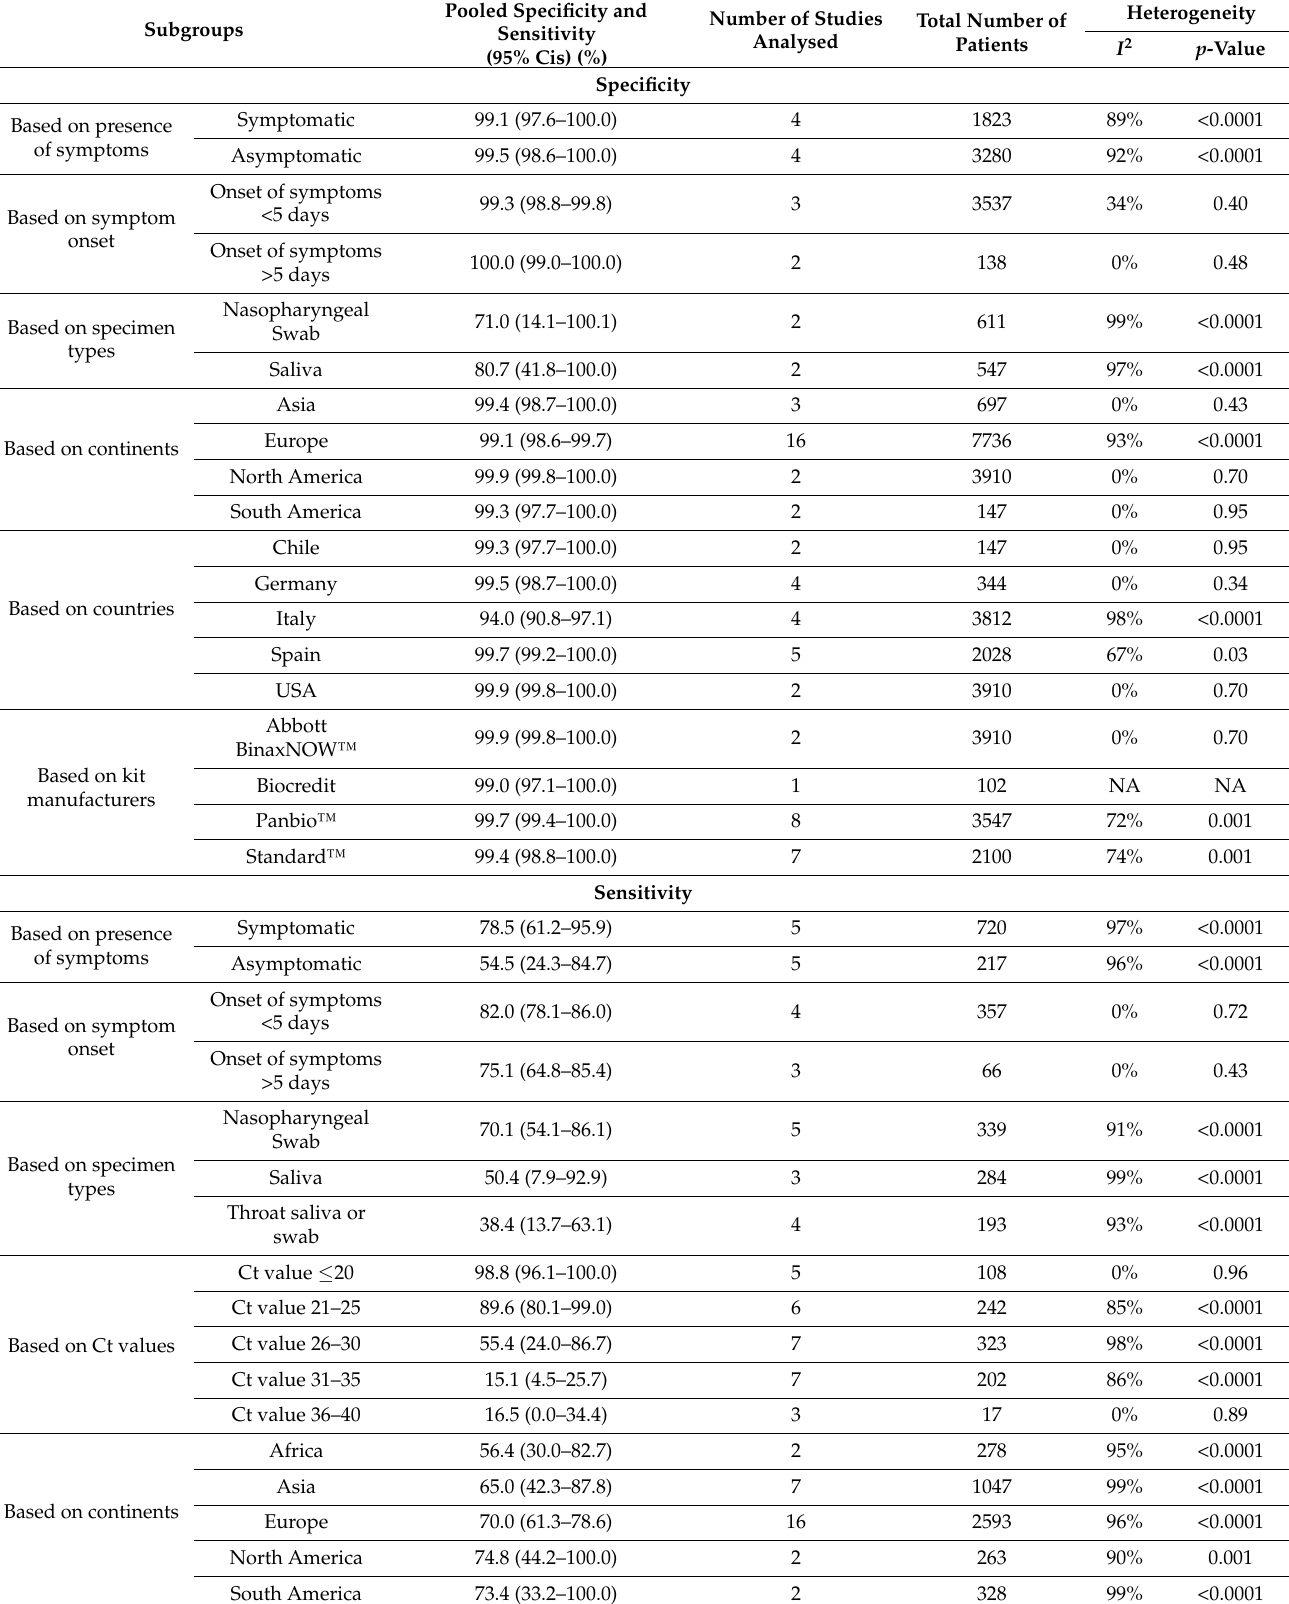
Table 2. Pooled specificity and sensitivity of SARS-CoV-2 detection using the rapid antigen test